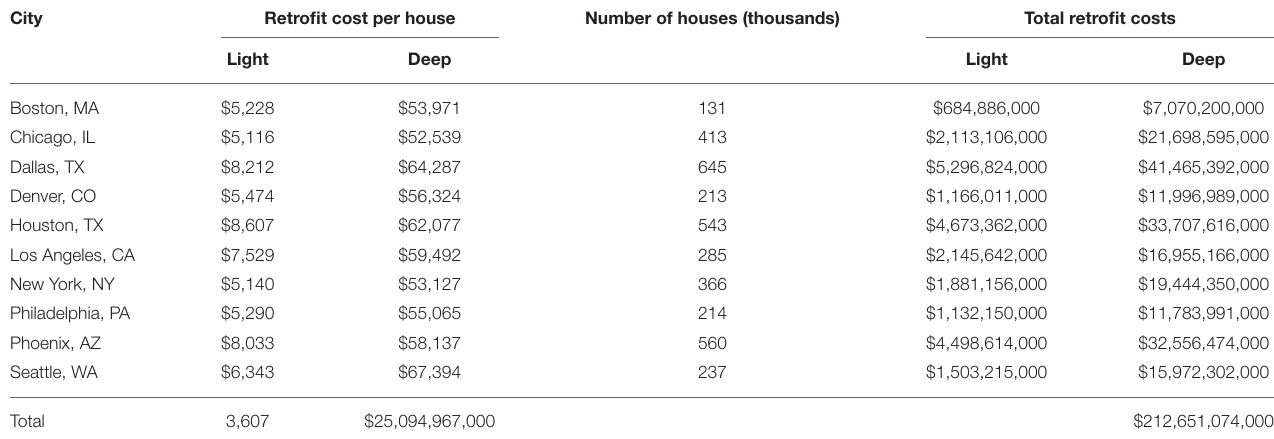
TABLE 4 | Estimated costs (2016 USD) of light and deep retrofits for single family detached homes built from 1990 to 2010 for city. City